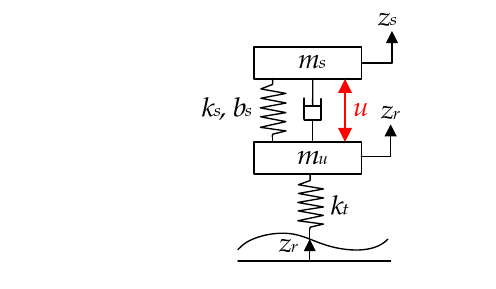
Figure 2. 2-DOF quarter-car model. The force acting on suspension is derived as (1). The equations of vertical motions of the sprung and unsprung masses are given in (2). By combining (1) and (2), and changing it into vector-matrix form, (3) is obtained.